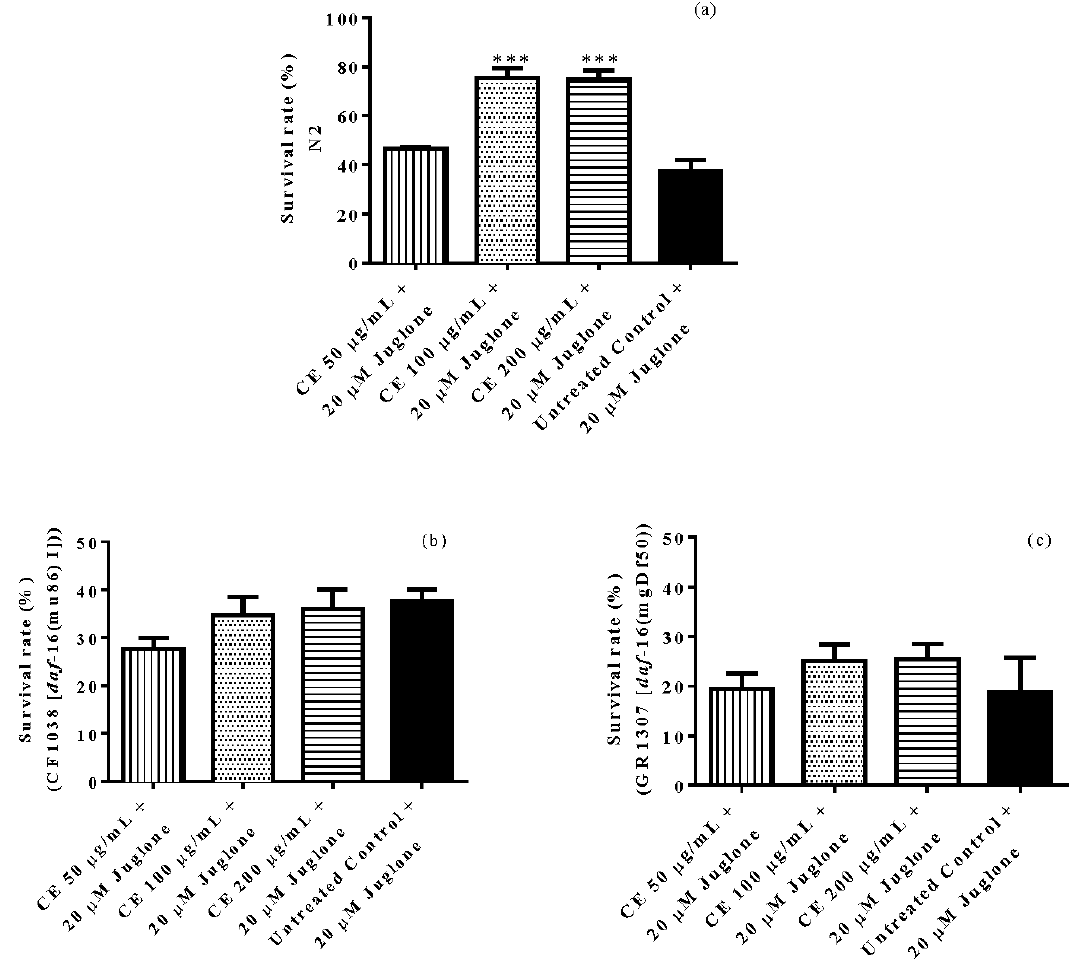
Figure 2. Survival of nematodes after juglone-induced oxidative stress. Survival rate of N2 worms was significantly enhanced in the groups treated with C. spruceanum extract (CE) ( a ). However, the survival rate of DAF-16 mutants CF1038 [ daf -16(mu86) I]) ( b ) and GR1307 [ daf -16(mgDf50) I] ( c ) was not different between the groups. Each bar represents the mean ± SEM from three independent assays. *** p < 0.001, compared to the untreated control by one-way ANOVA followed by Bonferroni (post- hoc).